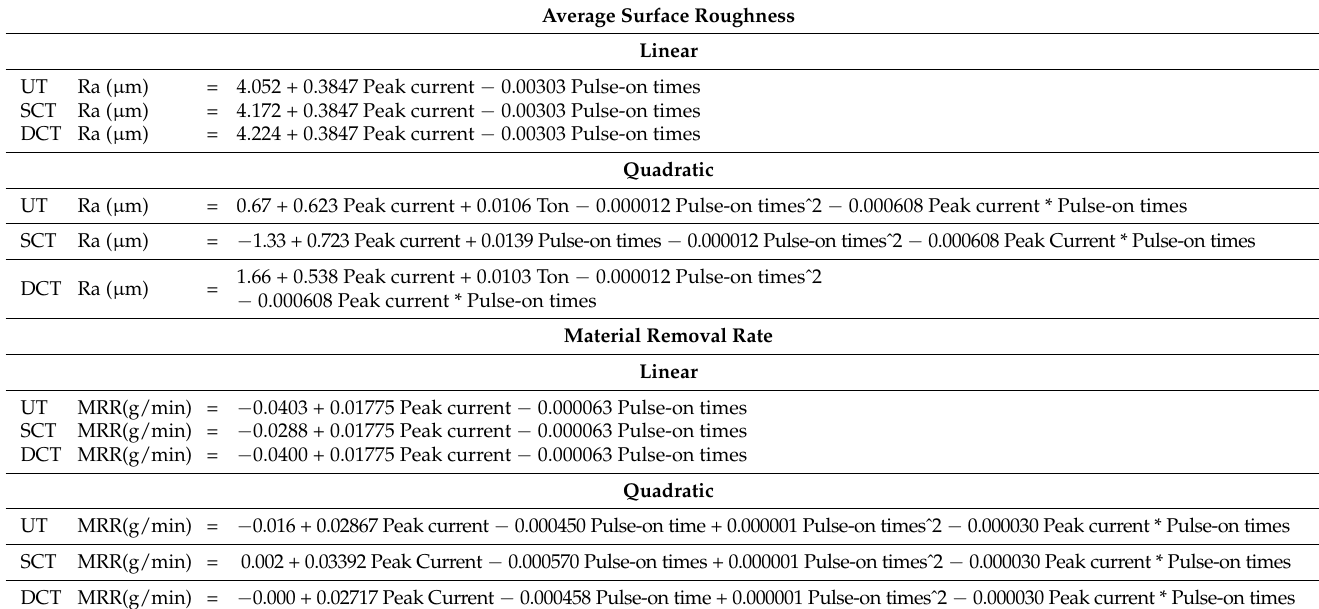
Table 10. Equations for the estimation of average surface roughness and